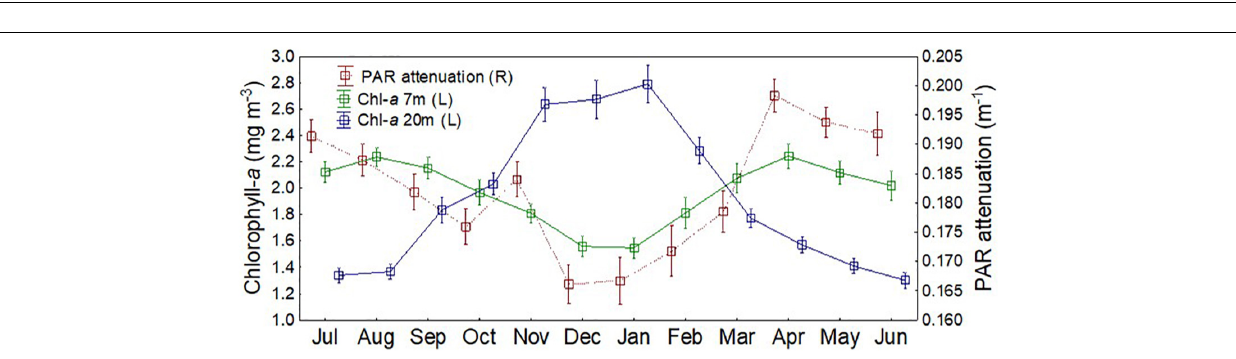
FIGURE 7 | Vertical sections of water-column properties from the inner Firth to the outer Hauraki Gulf on the transect shown in Figure 1B , in spring, summer, autumn, and winter 2012–13 and in autumn 2010. Properties are (A) chl- a and (B) phaeopigment- a (mg m − 3 ), (C) NO 3 − –N and (D) NH 4 + -N ( µ mol L − 1 ), (E) water transmissivity (%), (F) stratification (Brunt Väisälä frequency, cycles h − 1 : higher values mean more strongly stratified), and (G) O 2 ( µ mol kg − 1 ). Dots are depths of CTD bottle samples and vertical lines are 1-m interval CTD-derived values. An additional mid-Gulf station was occupied in autumn 2010. The segments in the first row show horizontal extent from the inner to the outer Firth ( Figure 1B ).